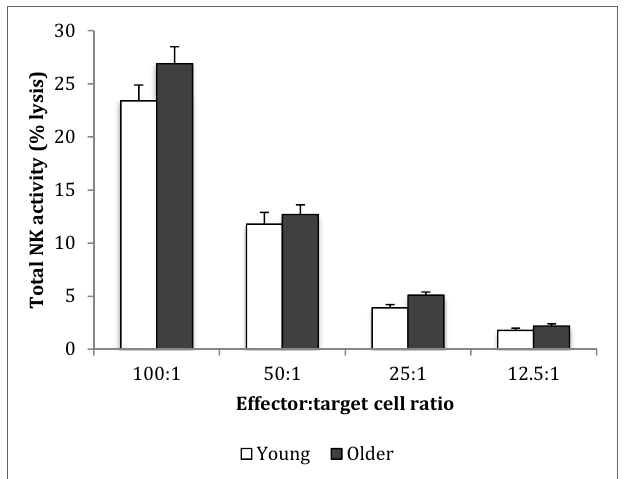
FiGUrE 2 | Baseline natural killer cell activity. Data are mean ± SEM at week 0, for n = 54 subjects per group. Data were analyzed using independent samples t -test (2-tailed). P = 0.11 for E/T ratio 100:1, P = 0.54 for 50:1, P = 0.03 for 25:1, and P = 0.08 for